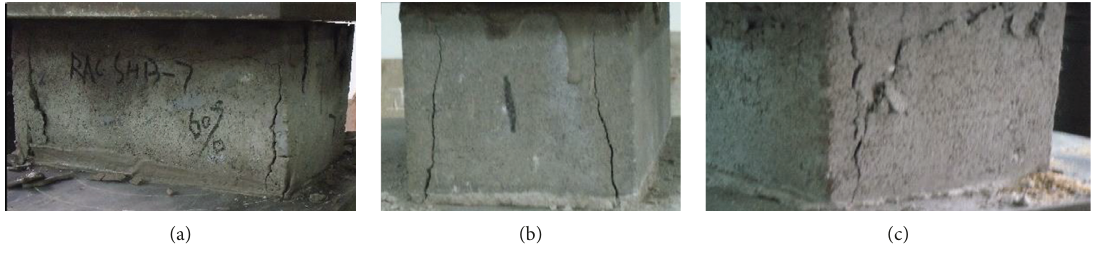
Figure 7: Damage form of specimens under pressure. Table 6: Compressive strength of recycled concrete hollow block test recording and